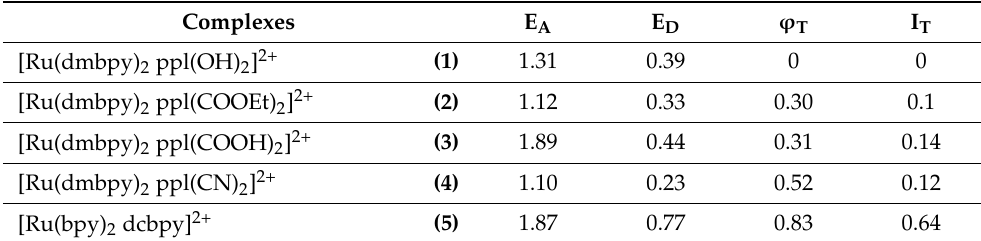
Table 4. Calculated values of I T for R 2 ppl complexes.